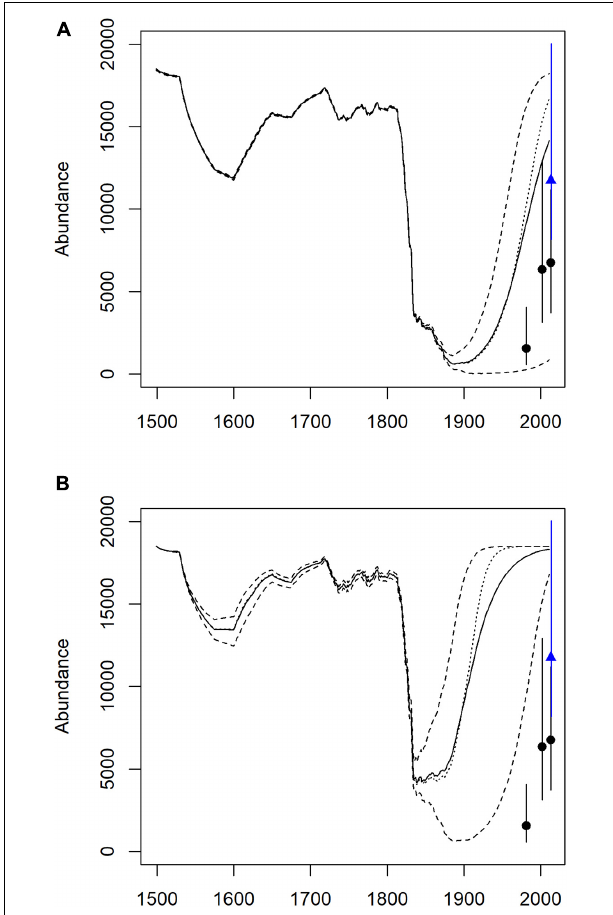
FIGURE 3 | ECWG bowhead whale population trajectory from a logistic population growth model estimated using historical catch data. Upper panel (A) is model results (solid line mean and dashed 95% confidence intervals) with a 26 y delay to represent bowhead whale age of maturation. Lower panel (B) is model results with a modified density-dependent shape parameter ( γ ) constrained between 1.8 and 1.9 and with R max constrained between 3.8 and